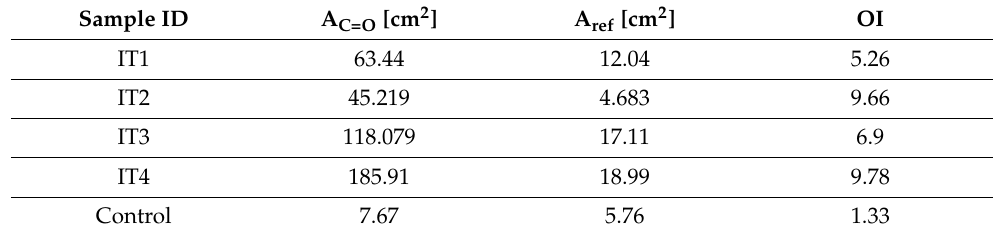
Table 4. Oxidation index computation for retrieved and control samples characterized based on FTIR